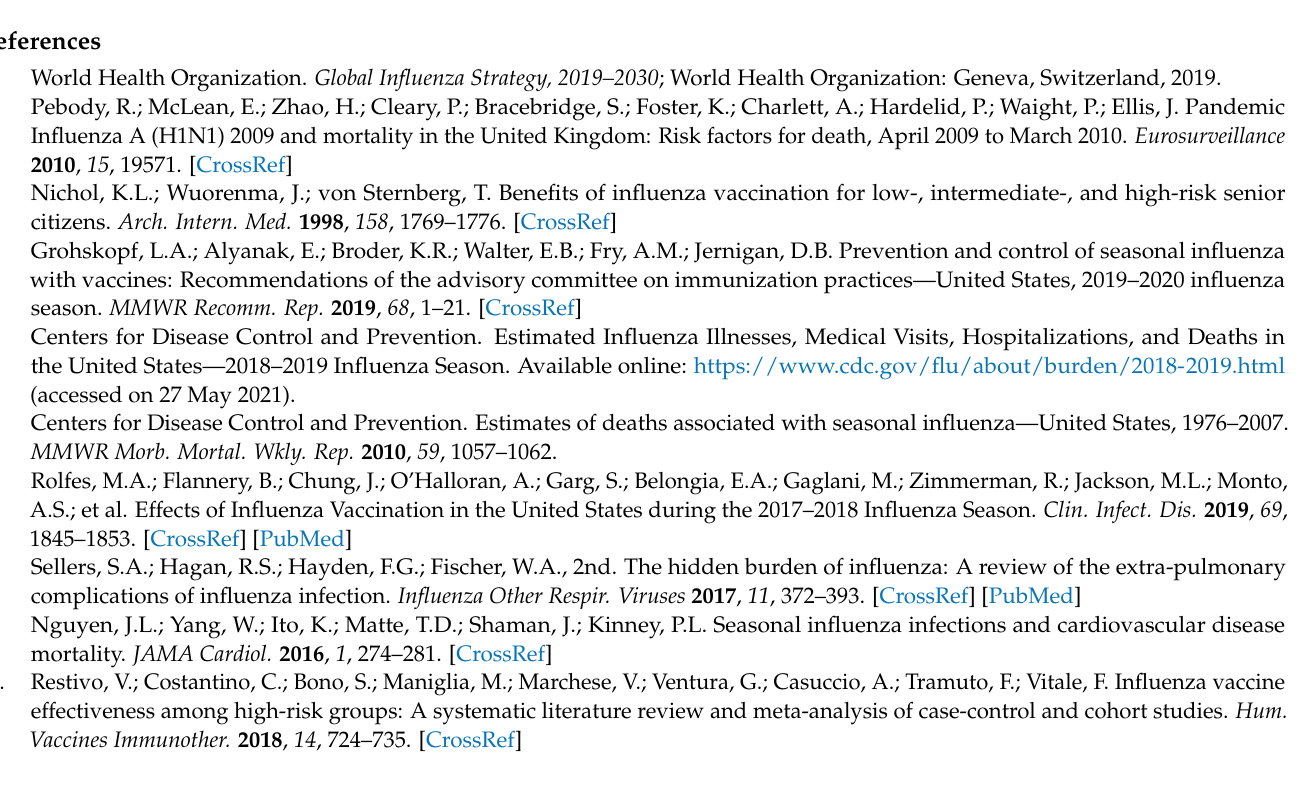
seasons by age group, Figure S1: Standardized mean differences between aIIV3 and